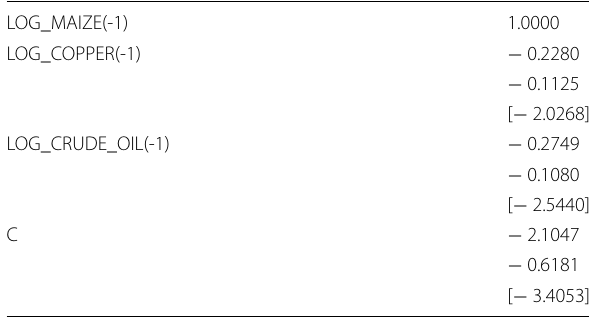
Table 9 Long-run effects of crude oil and copper prices on maize